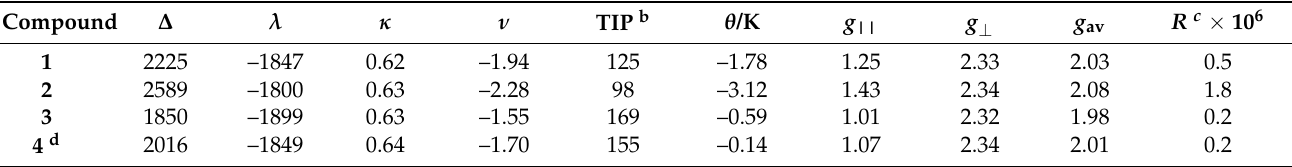
Table 3. Best- fi t parameters for 1 – 4 a . Compound